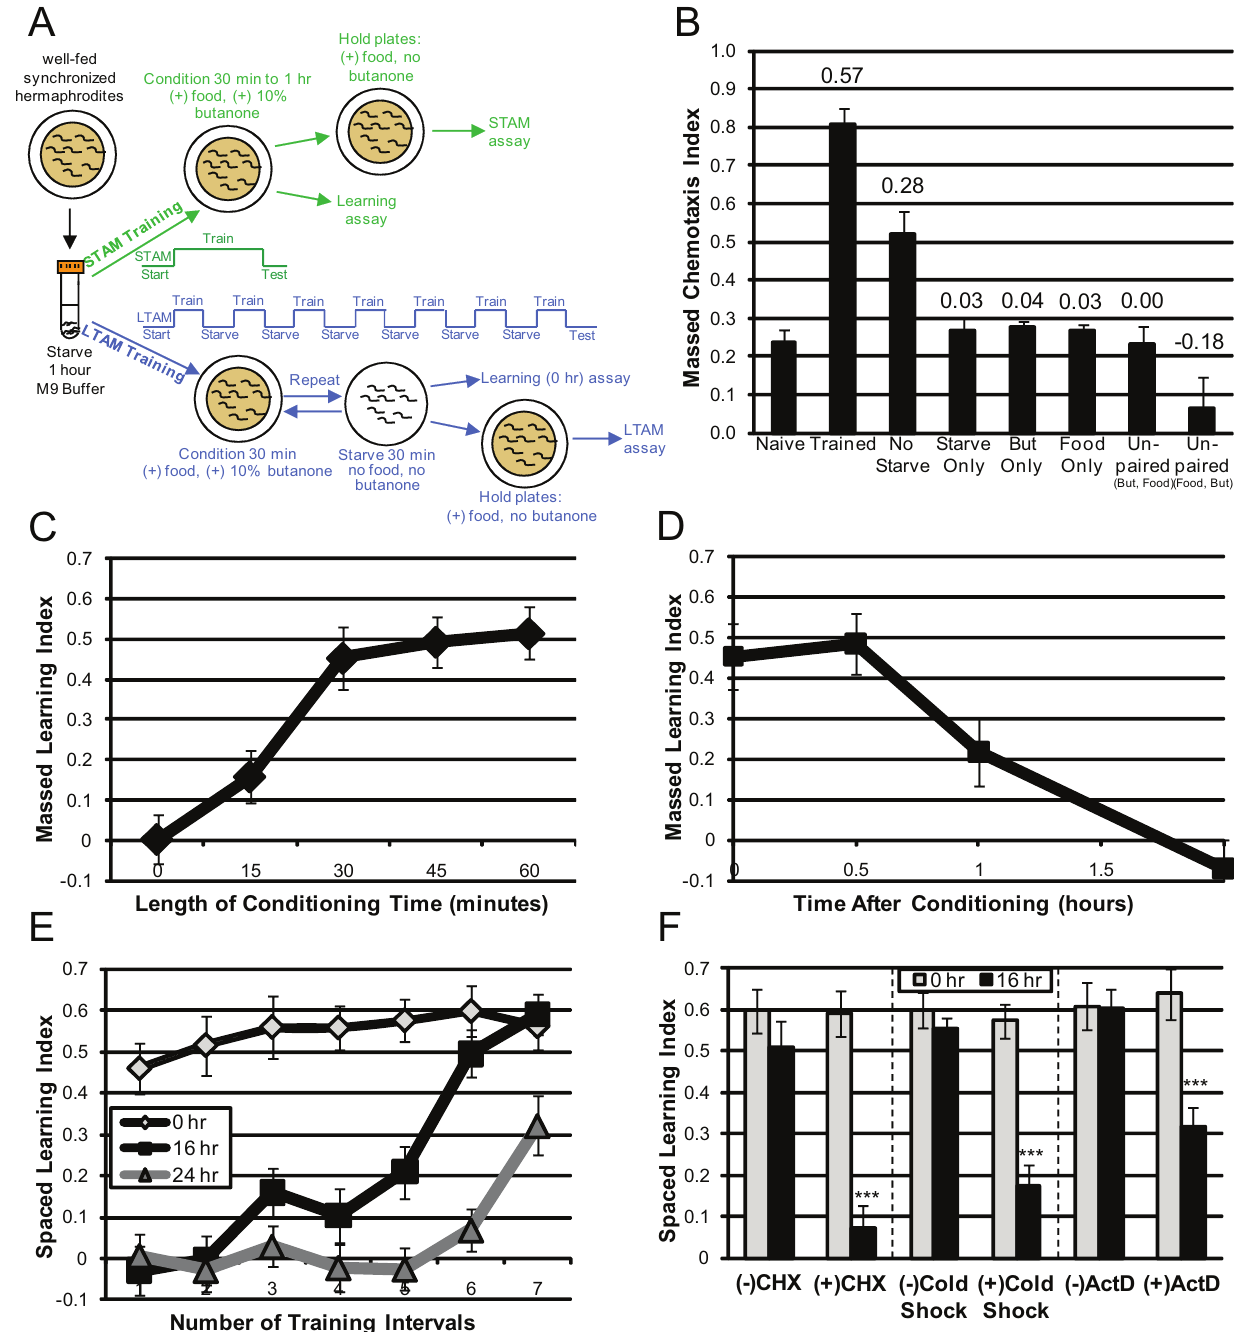
Figure 1. C.elegans learn and remember a positive association between food and the weak chemoattractant butanone. (A) Positive associative olfactory learning and memory assays. Well-fed worms are starved, then fed in the presence of 10% butanone; testing immediately after a single (massed) training measures learning, and short-term associative memory (STAM) is measured after an interval without exposure to butanone. Long-term associative memory (LTAM) is measured after several intervals of (spaced) training. (B) C. elegans positive associative learning. Worms were tested for chemotaxis toward 10% butanone before (Naı¨ve) or after conditioning massed training (Trained). Control conditioning paradigms include conditioning training without the 1 h pre-starve, starving for 1 h alone, conditioning training with food alone, 10% butanone alone, or unpaired (butanone then food or food then butanone). Chemotaxis Index (CI) = ( # at Butanone 2 # at Control)/(Total # 2 # at Origin). Learning Index (shown above bars) is calculated by subtracting the naı¨ve CI from the post-conditioning training CI. (C) Wild-type 1 6 massed learning is saturated after 30 min of conditioning training with food and butanone. (D) Short-term memory of butanone association is lost by 2 h. (E) 16 h and 24 h LTAM increases with number of spaced training trials and requires butanone during spaced training (Figure S1E). (F) Disruption of protein synthesis (cycloheximide or cold shock) or transcription (actinomycin D) decreases LTAM but does not affect spaced learning performance. (B–F): n =6 trials; 6 SEM; *** p , 0.001.